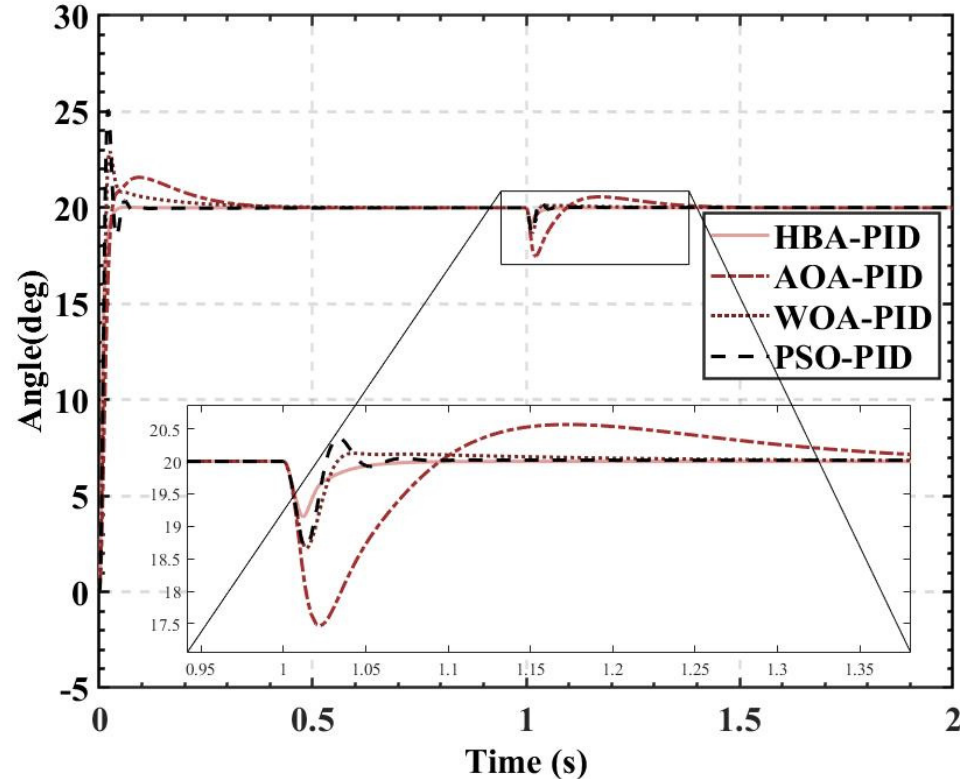
Figure 12. The actual angle of the balancing robot under HBA-PID, AOA-PID, WOA-PID, and PSO-PID algorithms after applying the external force.